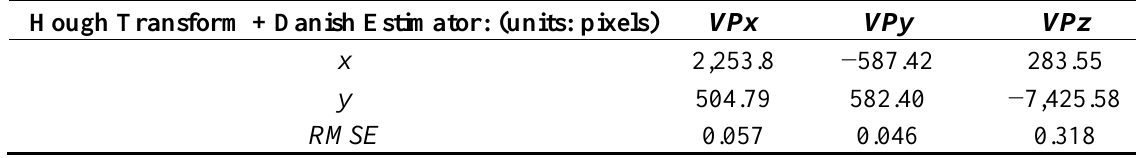
Table 2. Vanishing points coordinates and its